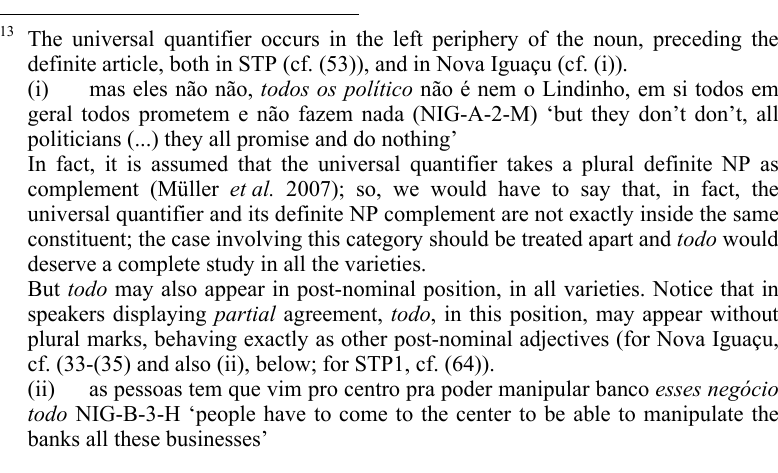
Table 7: Patterns of defective number agreement in the right periphery, in all varieties NIG STP1 STP2 ANG CV GUI MOC filhos pequeno  20 11 1 2 3 ponto  positivos 5 umas palavra  errada  13 4 1 1 1 esses transportes alternativo  17 18 2 2 2 2